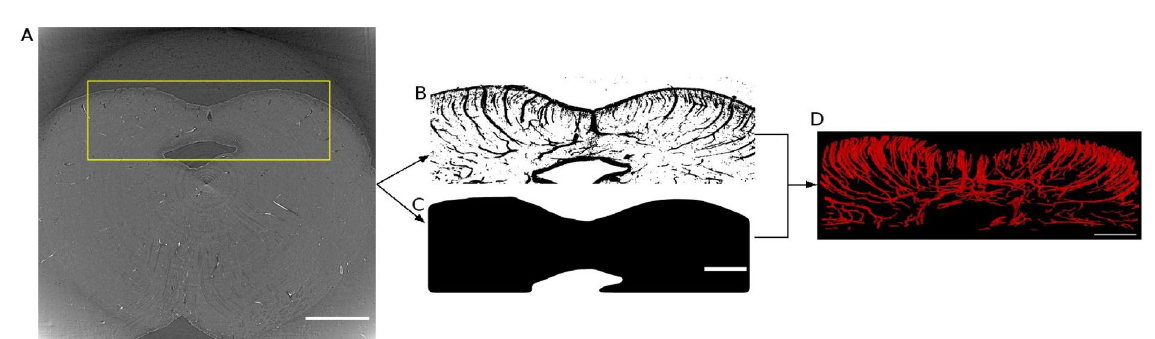
Figure 6. Vessel segmentation from phase-contrast microtomography with 4.94 µm voxel size. ( A ) Phase- contrast microtomography from sample 1. The yellow rectangle indicates the selected region covering the posterior midbrain. (Scale bar = 3 mm) ( B ) Result of applying Deriche-Canny edge detection on the selected region. Here, we present a maximum intensity projection of the edge detection result over 0.3 mm in Z direction for better visualization. ( C ) Mask used to identify the tissue (Scale bar = 1.5 mm). ( D ) Vessel segmentation result from the region with a 1.5 mm depth along the rostro-caudal